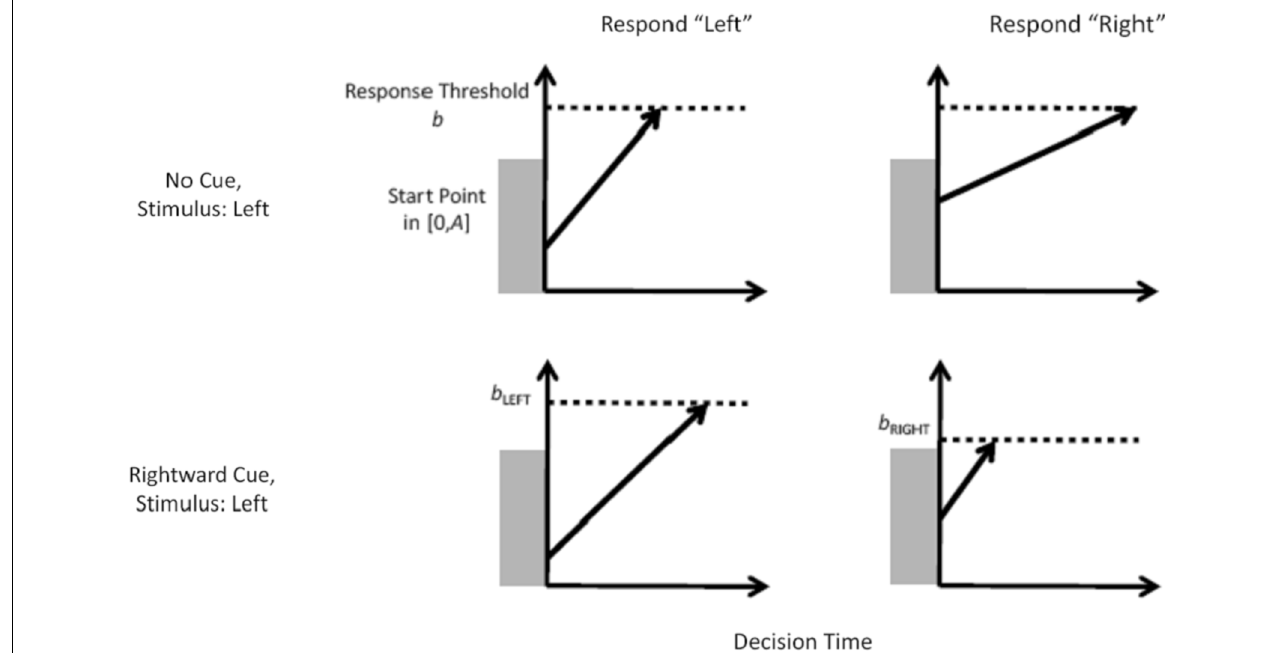
accumulation process is deterministic), but from one decision to the next the rate fl uctuates according to a normal distribution. A response is given by whichever accumulator fi rst reaches the threshold b (i.e., the horizontal dotted line), and the predicted response time depends on the time taken to reach that threshold. For a biased decision (bottom row), the accumulator corresponding to the cued response uses a lower response threshold than the other accumulator ( b